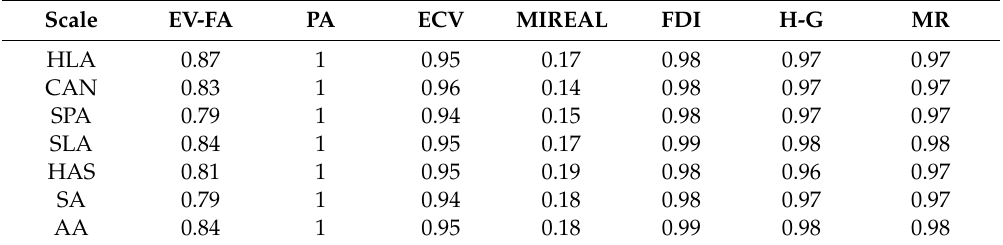
Table 3. Results of dimensionality, reliability, and local independence